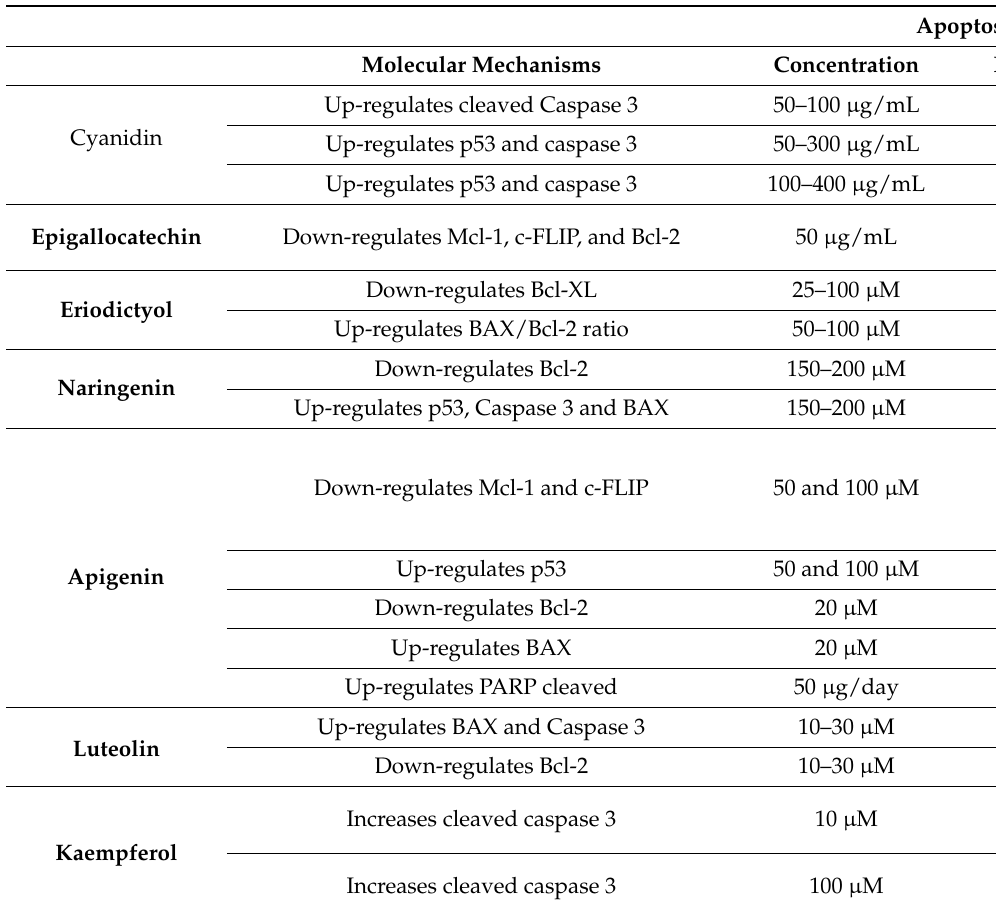
Table 7. Molecular mechanisms of flavonoids in apoptosis, cell cycle, DNA repair, and